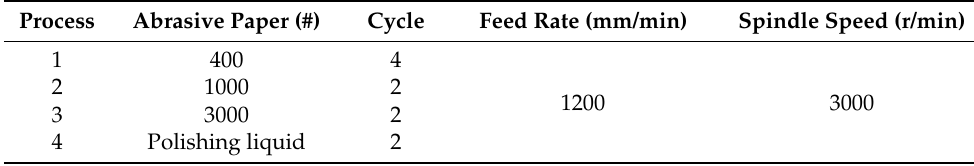
Table 4. Parameters setting in polishing process.